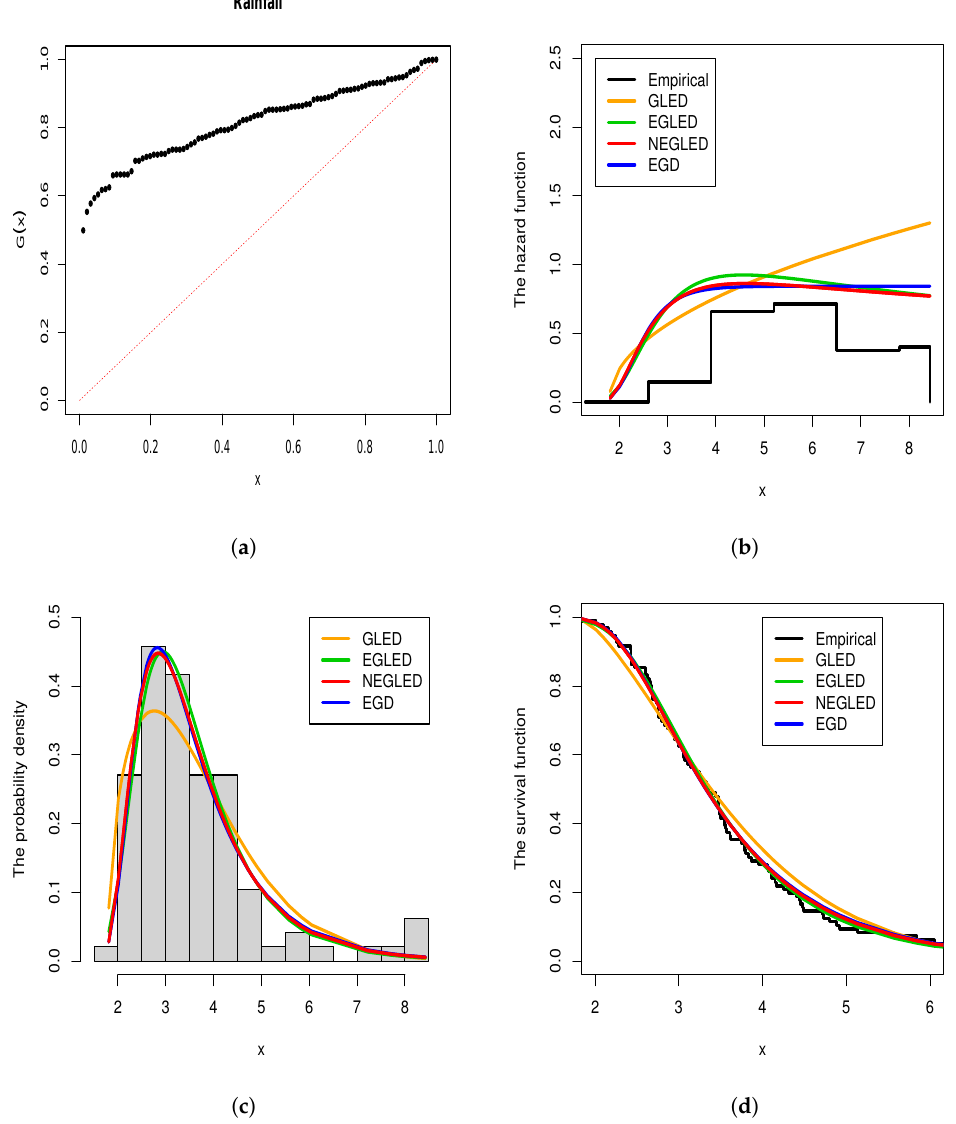
Figure 4. ( a ) The empirical TTT plot; ( b ) the empirical and estimated hazard functions; ( c ) the histogram and estimated PDFs; and ( d ) the empirical and estimated survival functions for the rainfall